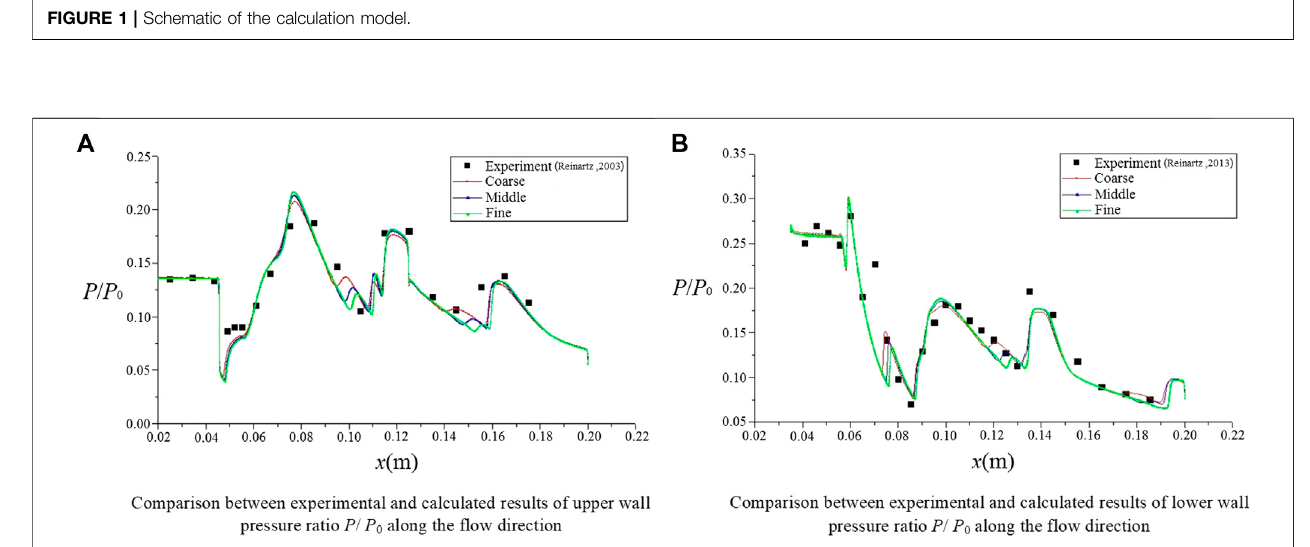
FIGURE 2 | Comparison of wall pressure distribution.